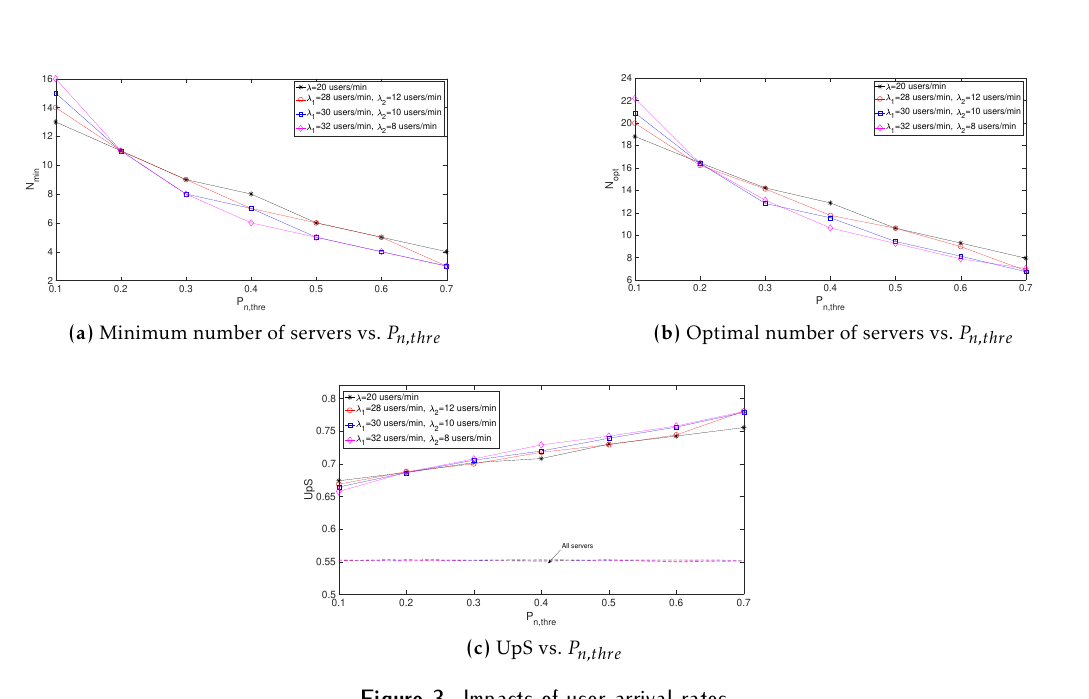
Figure 3. Impacts of user arrival